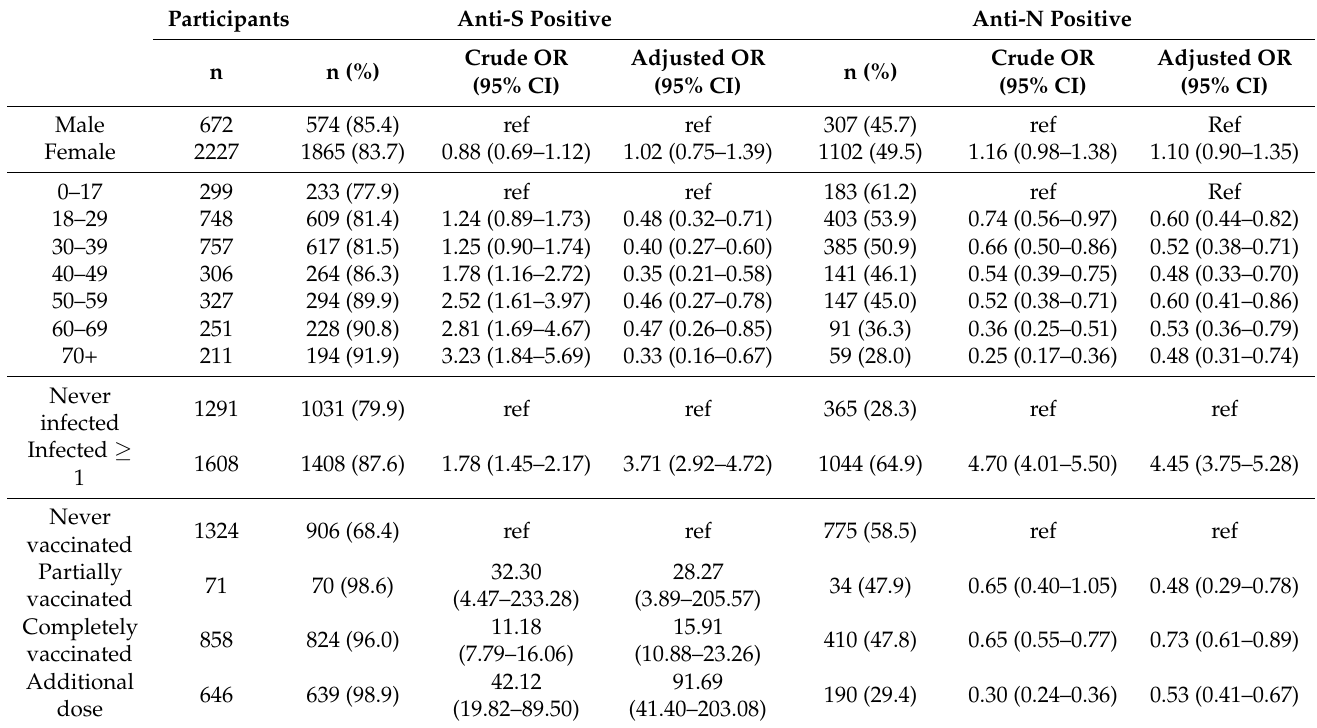
Table 1. Seroprevalence of anti-S and anti-N antibodies, stratified by gender, age group, previous SARS-CoV-2 infection, and